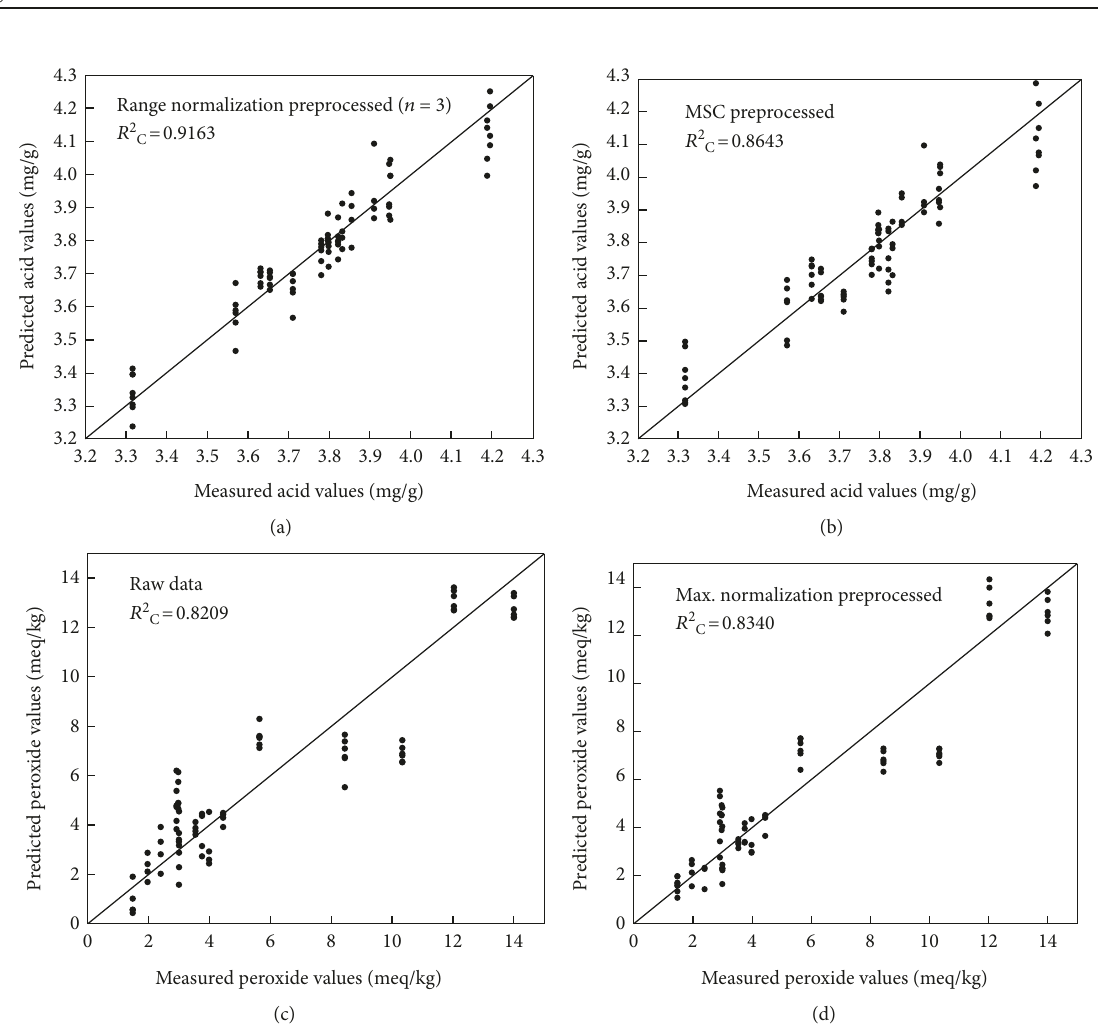
Figure 6: Prediction results of PLSR models for acid and peroxide values from the highest R 2 values. (a) Acid value with range normalization ( n = 3 ). (b) Acid value with MSC preprocessed. (c) Peroxide value with raw data. (d) Peroxide value with maximum